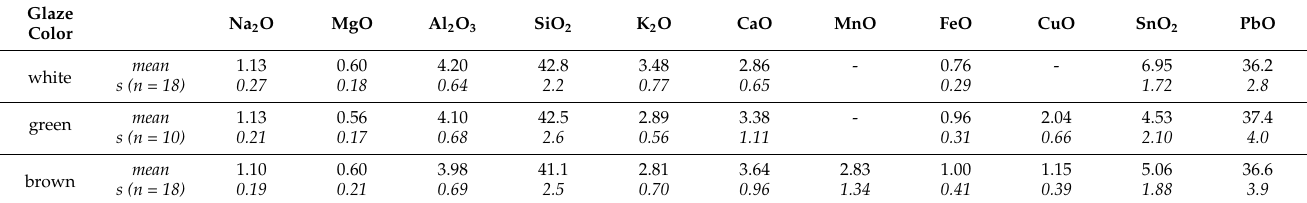
Table 2. Chemical composition (%wt) of white tin-opacified glazes and their colored decoration by EDS. Glaze